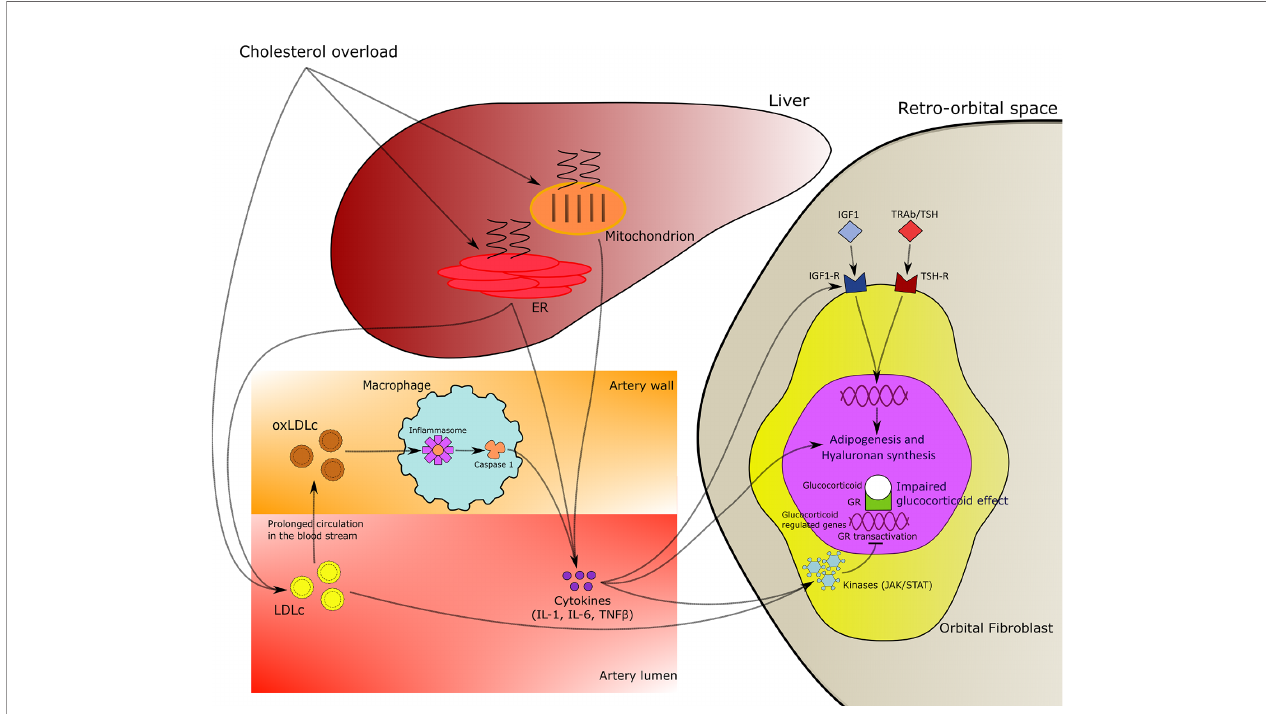
FIGURE 5 | Mechanistic hypothesis of relationship of hypercholesterolemia with chronic in fl ammation and resistance to corticosteroids effects in patients with Graves ’ ophthalmopathy